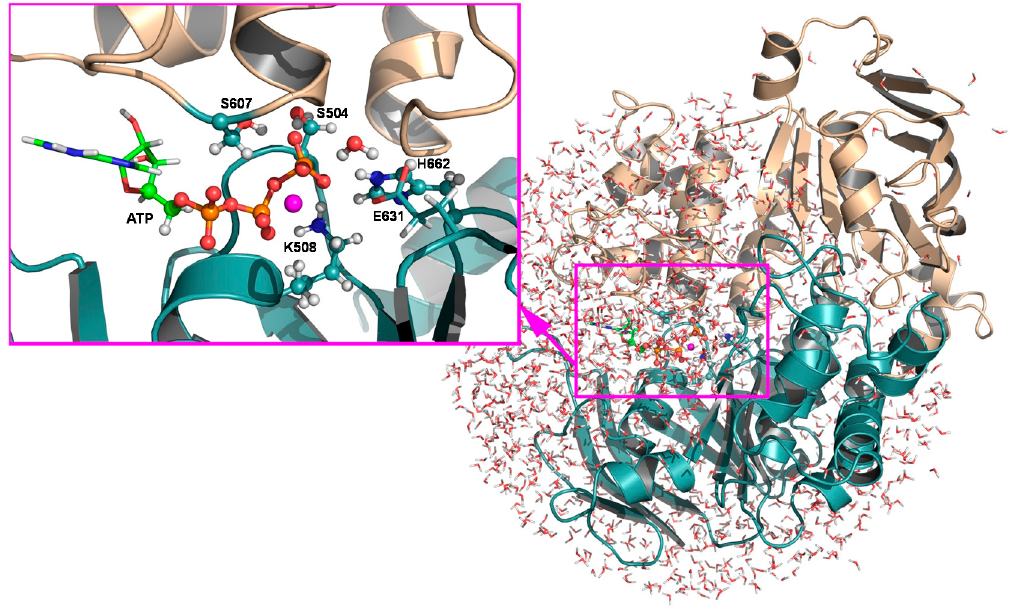
Figure 2. Stochastic boundary setup of the simulation system, where the active site is solvated by a water sphere of 30.4 Å, centered at the γ -phosphorous atom of ATP. Close-up of the QM region, which consists of three phosphate groups of ATP; side chains of S504, K508, and H662 in chain B of HlyB-NBDs; the side chain of S607 in chain A; the lytic water; and five GHO boundary atoms. The components shown in the licorice representation are originally located in the 1XEF structure, except side chains of H662 and E631, and the lytic water, which were modeled from the 2FGK structure. This figure was generated by PyMOL.